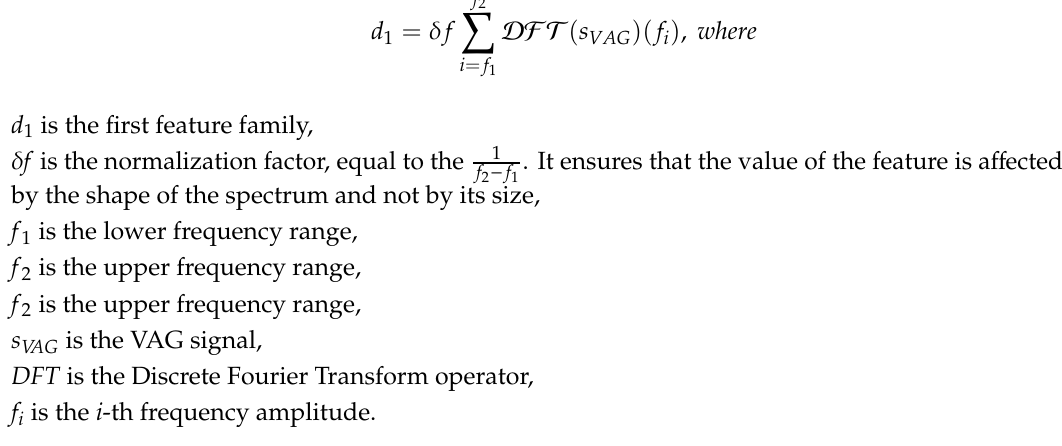
Figure 4. Visualization of the second and the fourth family of features: ( a ) the derivative of the analyzed VAG signal, ( b ) the spectrum of the ( a ), ( c ) the squared spectrum. The calculation of the feature values was followed by the evaluation by Bhattacharyya coefficient. The point with coordinates: x = lower frequency range, y = upper frequency range, z = the